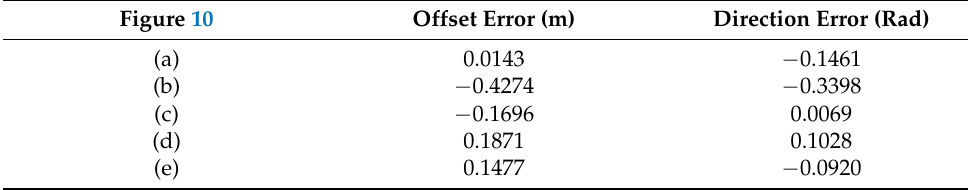
Figure 10. The local path planning of the proposed method for dataset 1 in the case of turning right, in which the red lines in ( a – e ) are shown as the local path planning of the proposed method. Table 2. The corresponding error in Figure